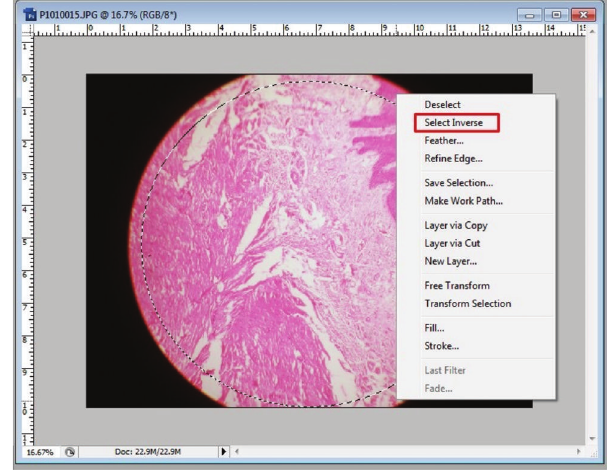
Figure 7: “Inverse selection” to delete extraneous portion of an image. Note the red boxes in the figure. Follow them for an easy